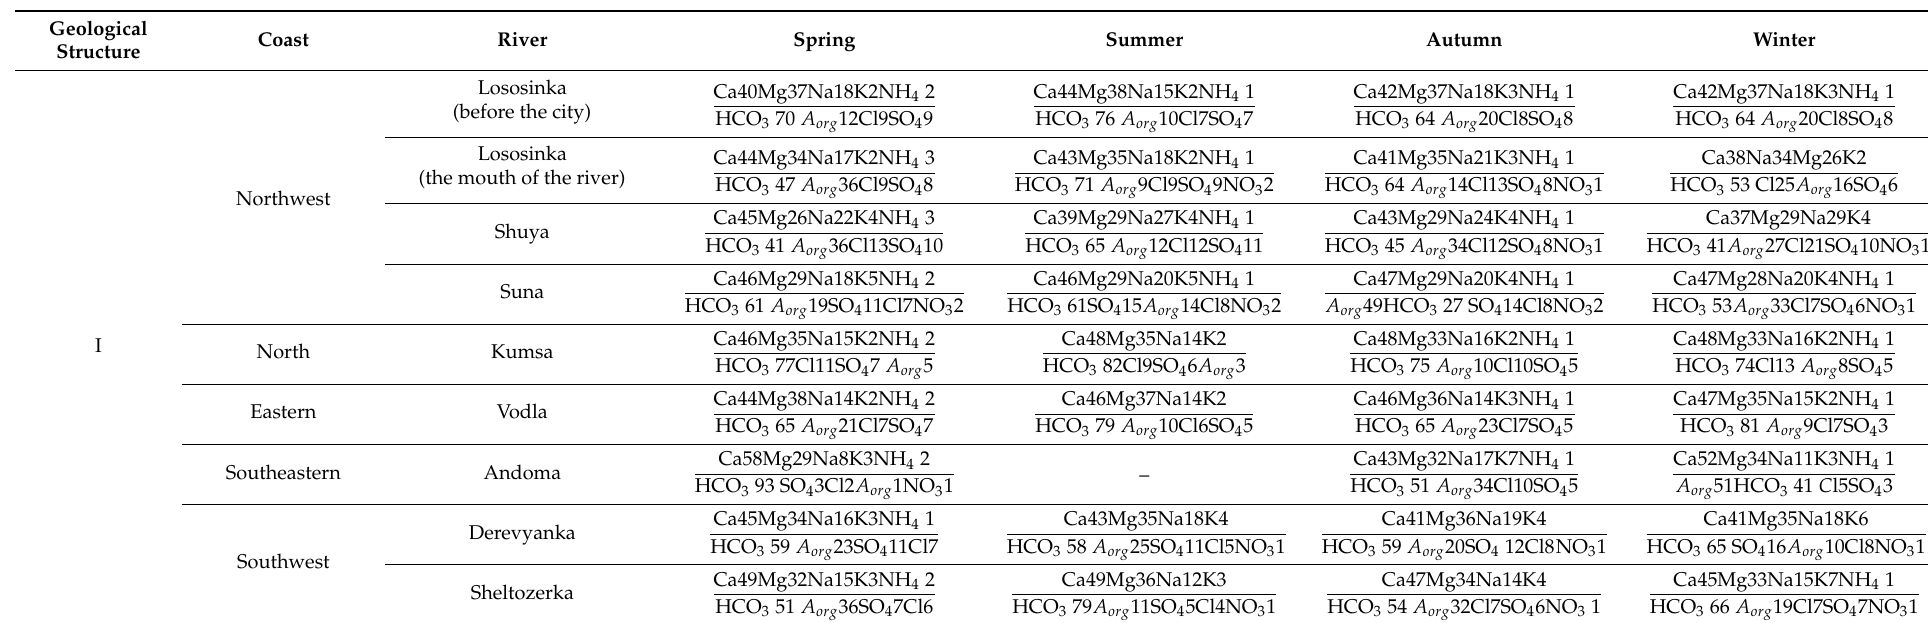
Table 3. Chemical composition of the river